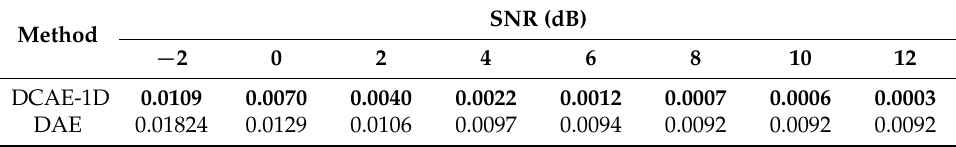
Table 11. Reconstruction error of DCAE-1D and DAE under different SNR .